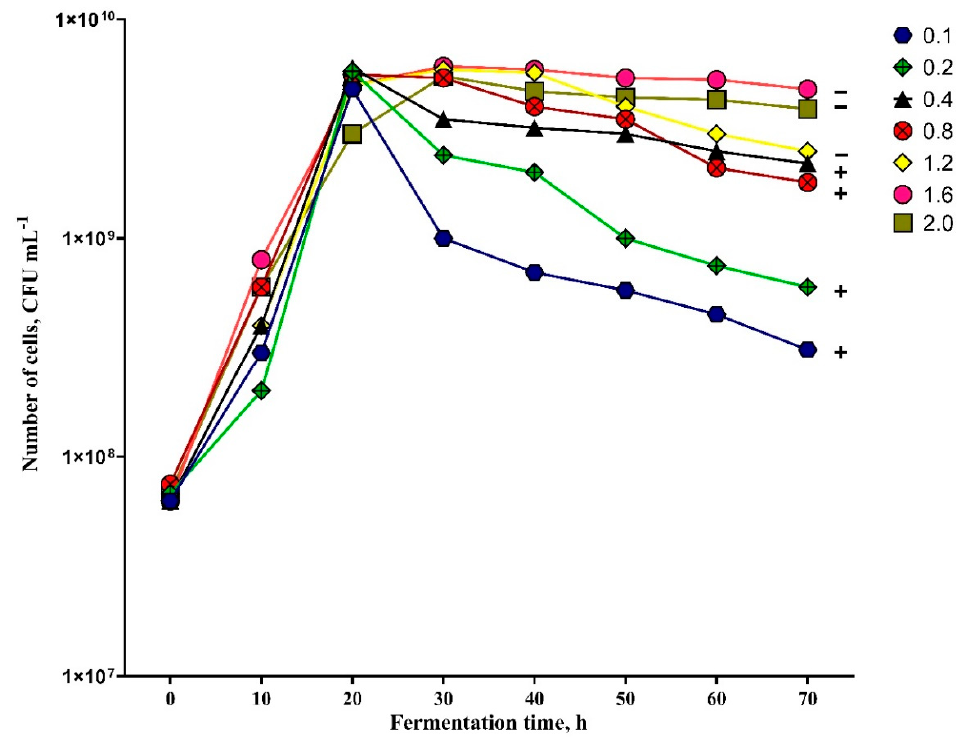
Figure 8. Effect of air flow on the biomass production of Paenibacillus sp. MVY-024. Differences between averages are significant at p ≤ 0.05.